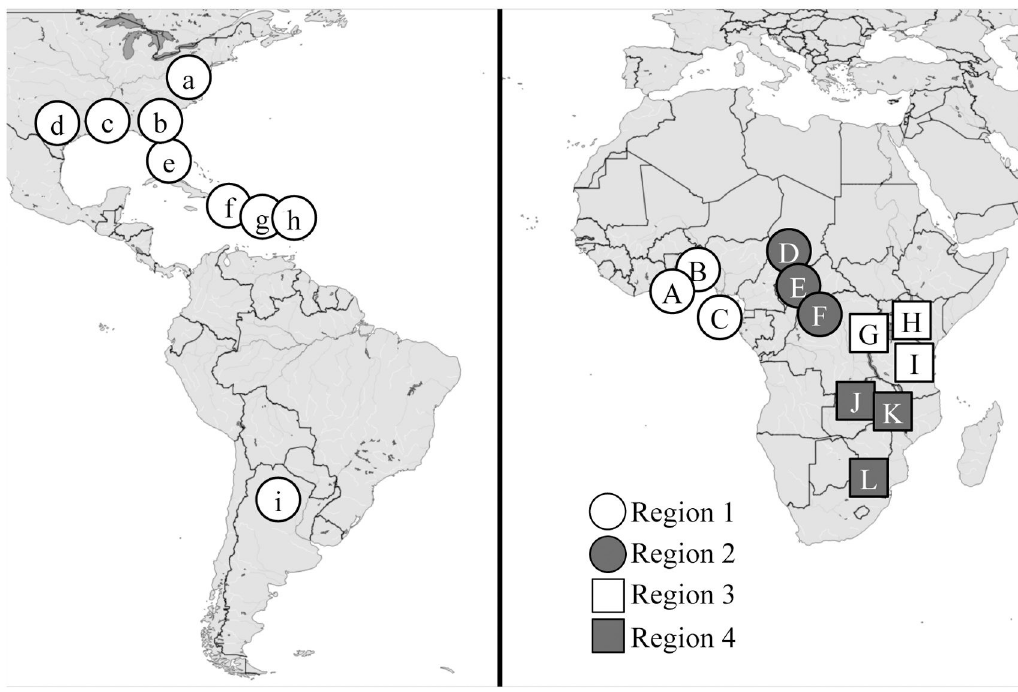
Fig 1. Map of the Western Hemisphere and Africa showing locations of fall armyworm collections. Letters refer to Table 1 (parenthesis). Africa collections were grouped into regions designated by shapes and shadings. The map was generated using the free and open source software QGIS version 2.18